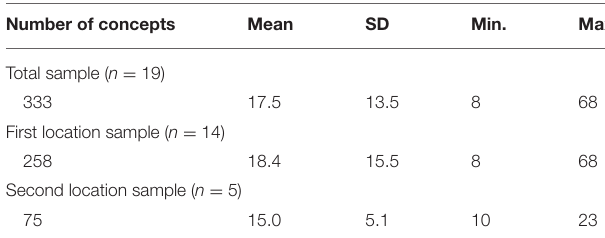
TABLE 1 | Descriptive statistics for the associated